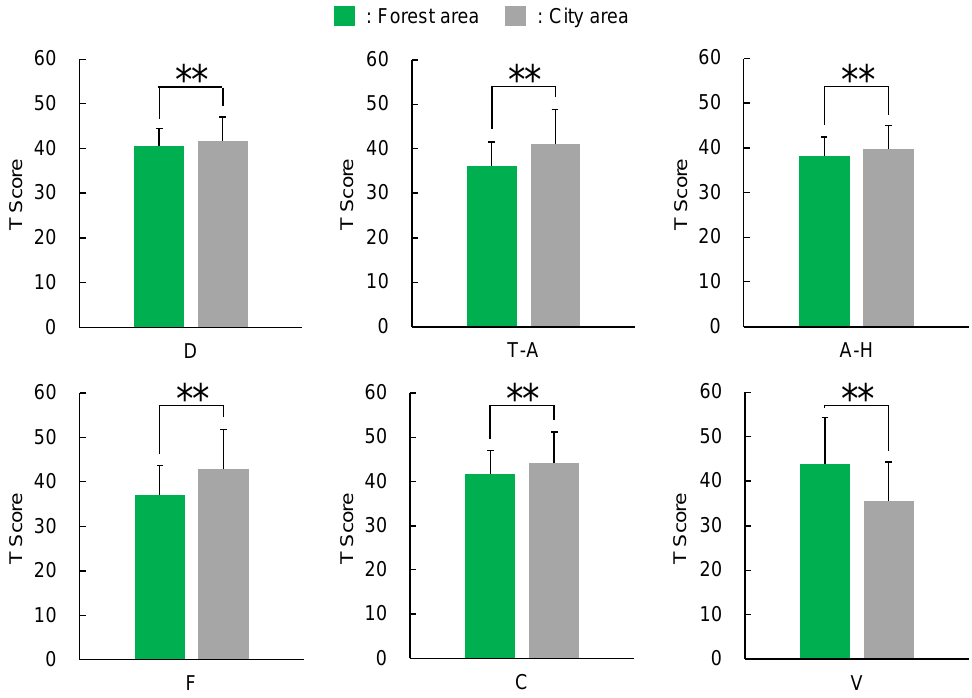
Figure 3. Scores of the Profile of Mood States after walking through forest and city areas. (D), depression–dejection; (T-A), tension–anxiety; (A-H), anger–hostility; (F), fatigue; (C), confusion; and (V), vigor. N = 585; mean ± standard deviation; **, p < 0.01 by Wilcoxon signed-rank test. Lines 5–14 on page 5 should be replaced with the following text: